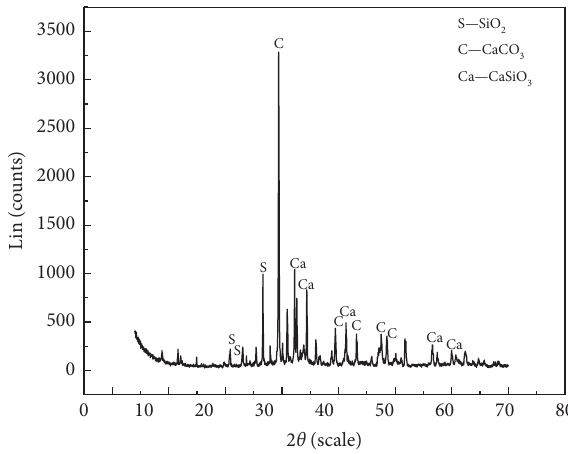
Figure 3: Red soil XRD diffraction analysis map.